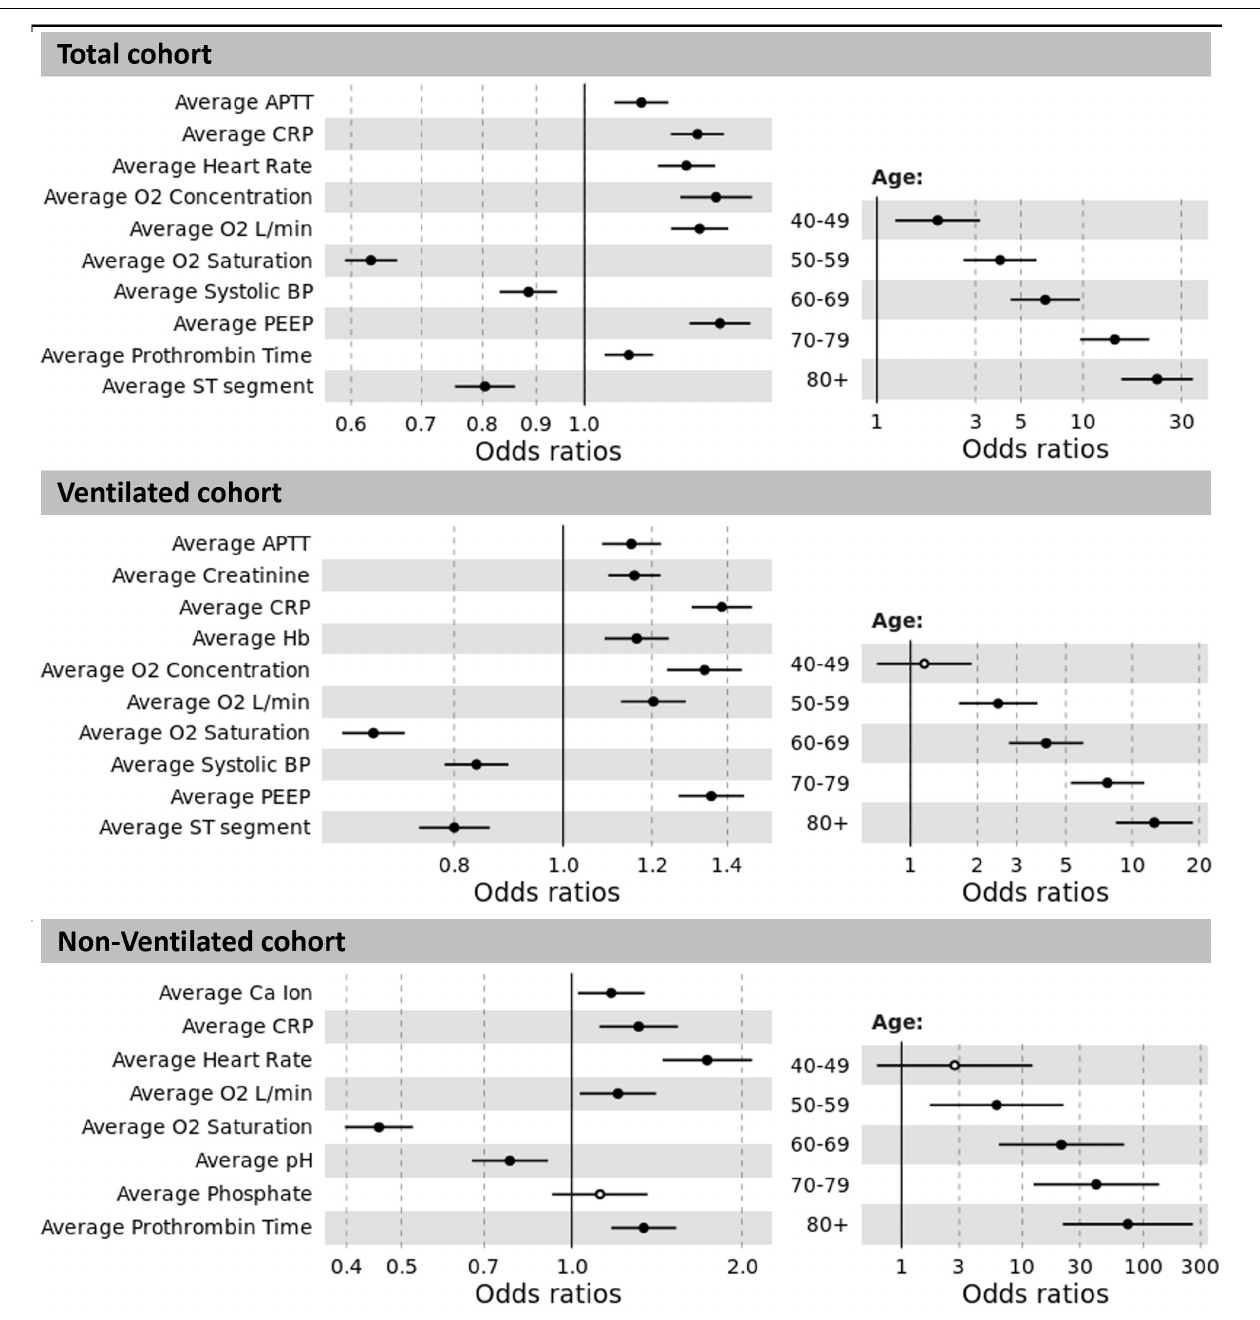
FIGURE 3 | Odds ratios between significant results and prediction of AF for the total cohort, ventilated and non-ventilated cohorts. The non-significant results are displayed as hollow points. Abbreviations: APTT: activated partial thromboplastin time; CRP: C-reactive protein; O2: oxygen; BP: blood pressure; PEEP: positive end-expiratory pressure; Hb: haemoglobin; Ca: